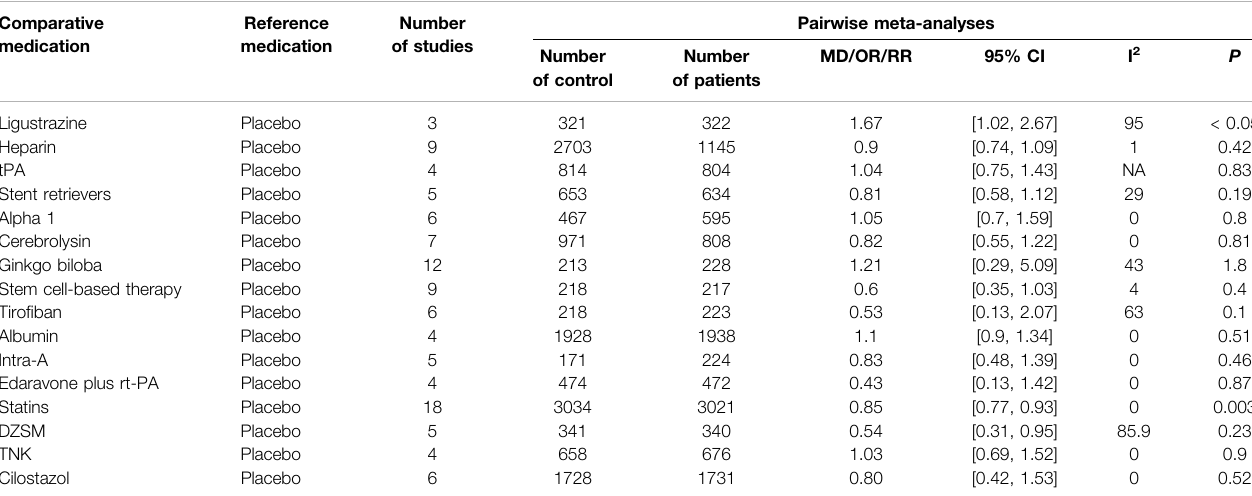
TABLE 8 | Results of pairwise meta-analyses for mortality. Comparative